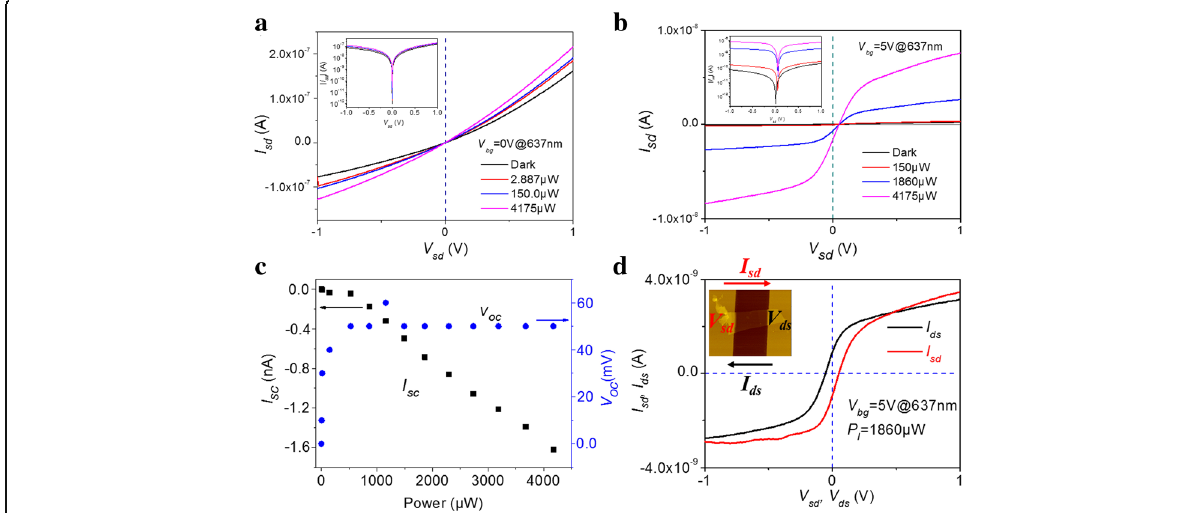
Fig. 2 Photoresponse of multi-layered MoTe 2 phototransistor illuminated by 637-nm wavelength laser in ambient condition. a I sd vs. V sd curves at V bg =0 V as illumination power increases. b power. d Output current for biased voltage loaded on the source and drain electrode,